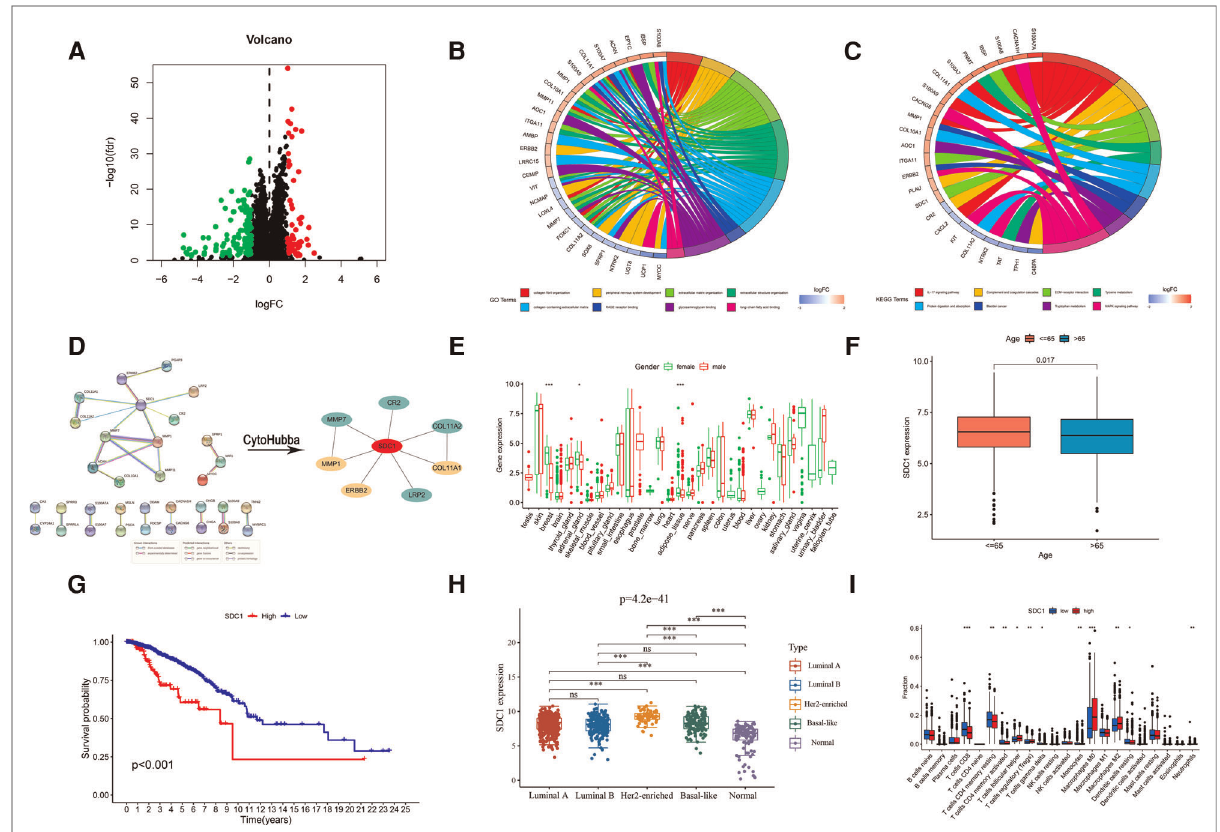
FIGURE 8 Screening and analysis of RDEGs. ( A ) Screening of RDEGs. ( B ) GO enrichment of RDEGs. ( C ) KEGG enrichment of RDEGs. ( D ) PPI of RDEGs and identi fi cation of Hub gene. Expression difference of Hub gene, including ( E ) Gender, ( F ) Age and ( H ) different types of breast cancer. ( G ) OS analysis of Hub gene. ( I ) Immune in fi ltration of Hub